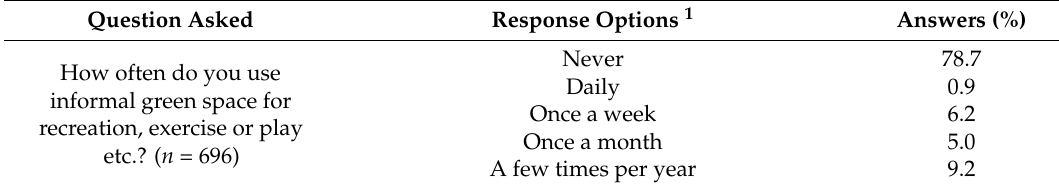
Table 4. Respondents’ use of IGS for recreational